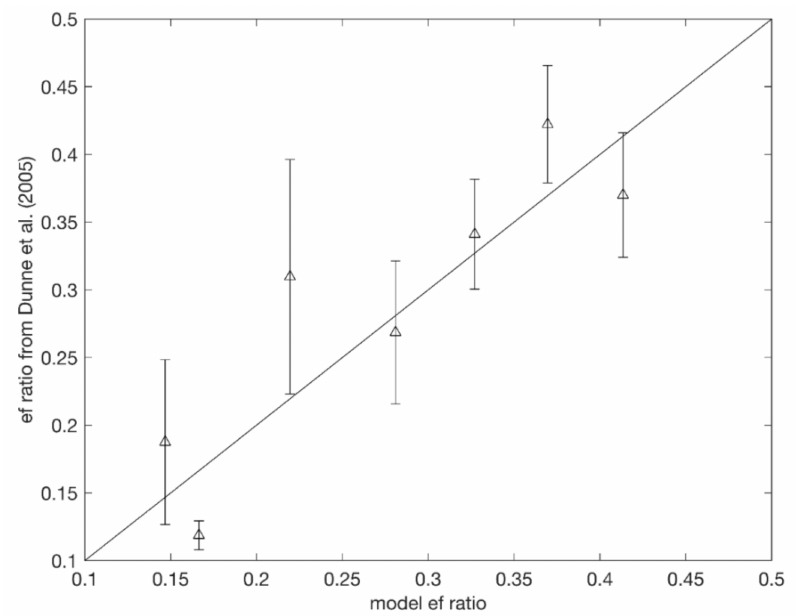
Figure 3. Comparison of ef ratios predicted by the food web model at a given temperature and NPP versus the ratios summarized by Dunne et al. [35]. The ratios have been binned into intervals of 0.05 from 0.10 to 0.45. Symbols show mean values in each interval, and error bars are the standard deviations of the data in each interval. The straight line is the 1:1 line.